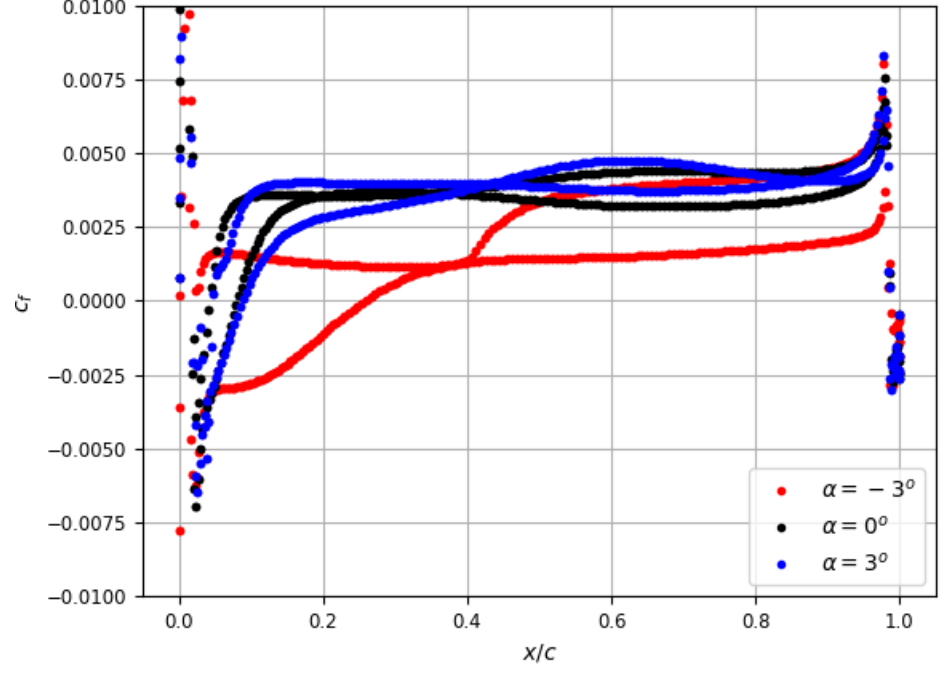
Figure 13. Distribution of the friction coefficient along the middle blade for M 2 is = 0.5 and α − 3°, 0° and 3°. Figures 14 and 15 show the distribution of the static pressure along the inlet and outlet probe lines for two extreme angles. The coordinate l is measured from the lower left point of the line (see also Figure 9). One can see a variation in the pressure across the channel which corresponds to variation of the Mach number mentioned before. Figures also include the experimental data taken in 11 evenly distributed pressure probes along the inlet line and 20 probes along the outlet line. Table 1 gives the values of the outlet reference Mach number M o calculated from the CFD results.